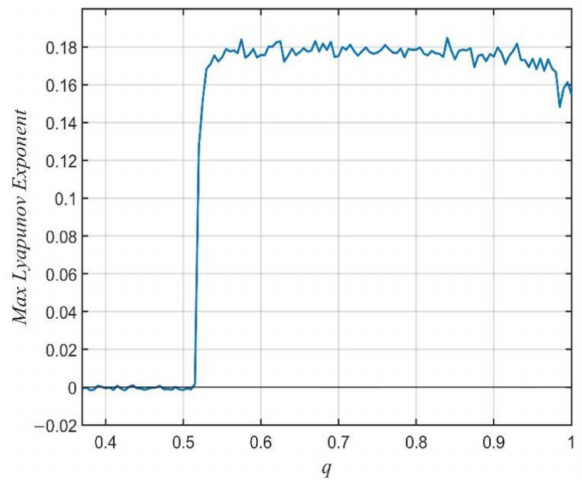
Figure 6. Maximum Lyapunov exponent of system (14) with q varying from 0.37 to 1 for a 1 = 0.3.